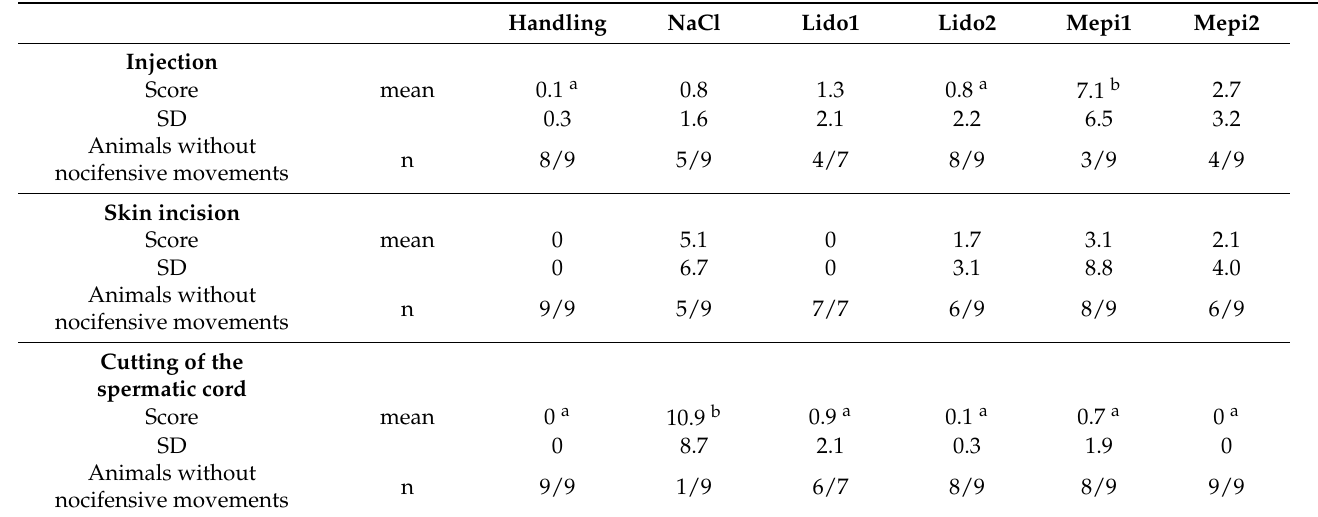
Table 4. Nocifensive scores mean ± SD and number of piglets without nocifensive movements during injection, skin incision and cutting of the spermatic cord. Handling NaCl Lido1 Lido2 Mepi1